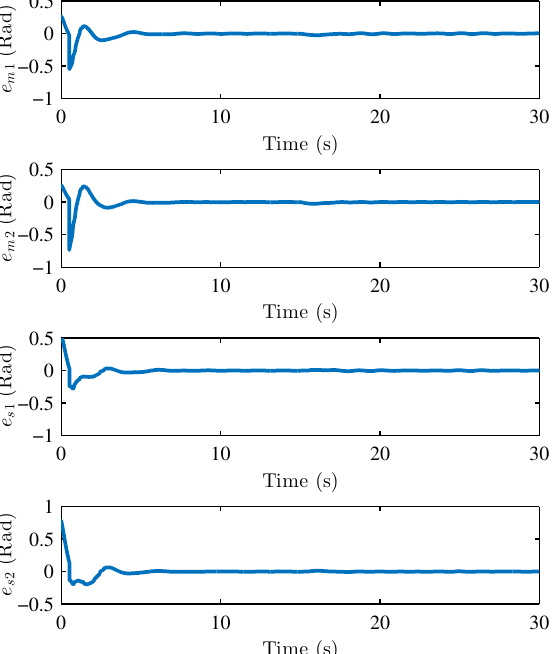
Figure 5. Position tracking errors at master side e m 1 , e m 2 and slave side e s 1 , e s 2 .